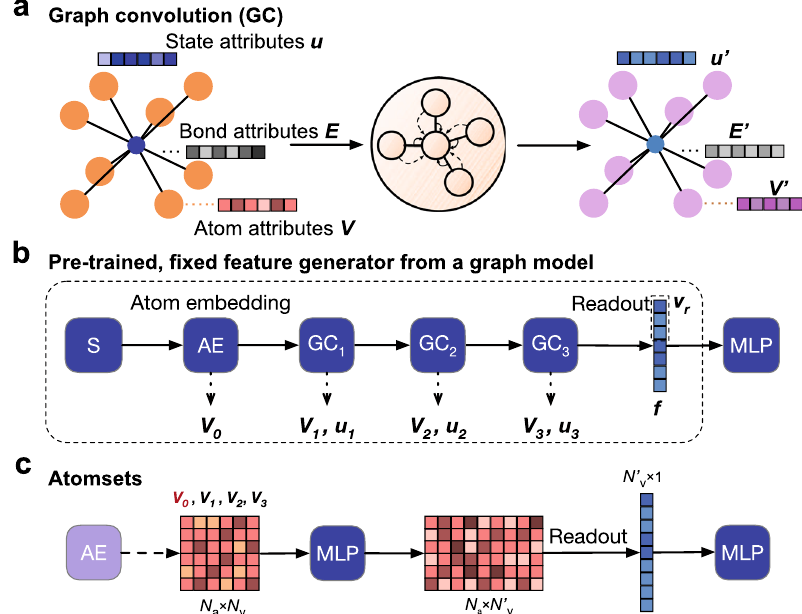
Fig. 1 Graph networks and AtomSets schematics. a The graph convolution (GC) takes an input graph with the labeled atom ( V ), bond ( E ), and state ( u ) attributes and outputs a new computed graph with updated attributes. b The graph network model architecture. The input to the model is the structure graph (S) with atomic number as the atom attributes. Then the graph is passed to an atom embedding (AE) layer, followed by three GC layers. After the GC, the graph is read out to a structure-wise vector f , and f is further passed to multi-layer perceptron (MLP) models. Within the model, each layer output is captured for later use. c The AtomSets model takes a site-wise/element-wise feature matrix and passes to MLP layers. After the MLP, a readout function is applied to derive a structure-wise/formula-wise vector, followed by fi nal MLP